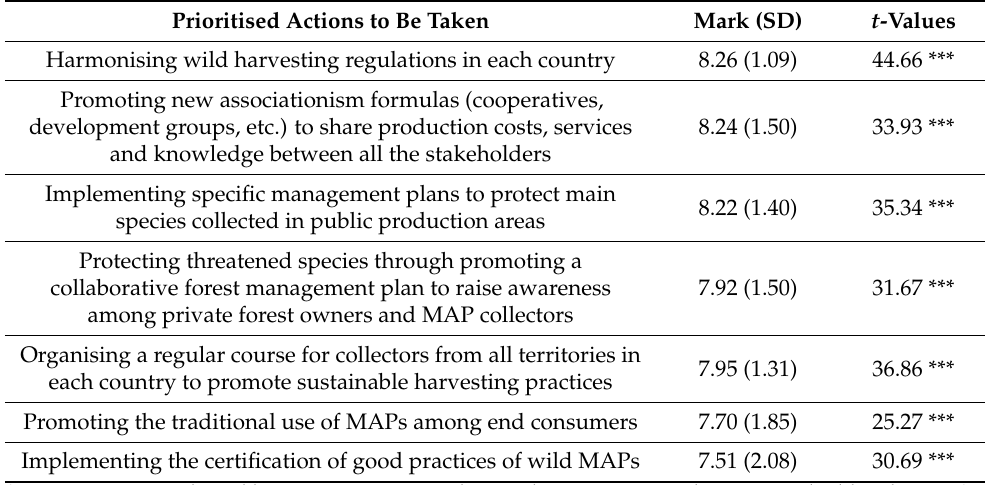
Table 3. Top prioritised actions to be taken in the MAPs sector identified by expert panel at the end of the second round (only marks higher than 7.5 are considered in the